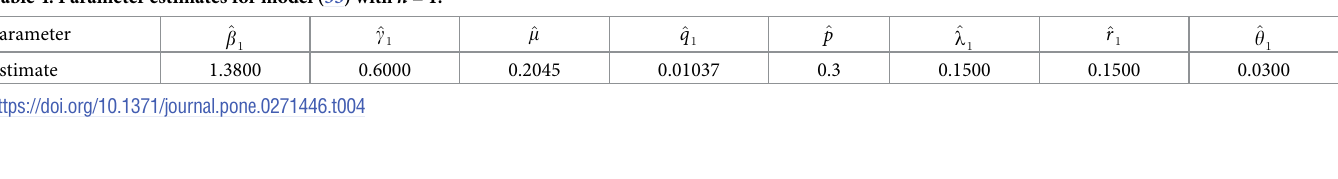
Fig 8. Stability analysis for the case where R λ